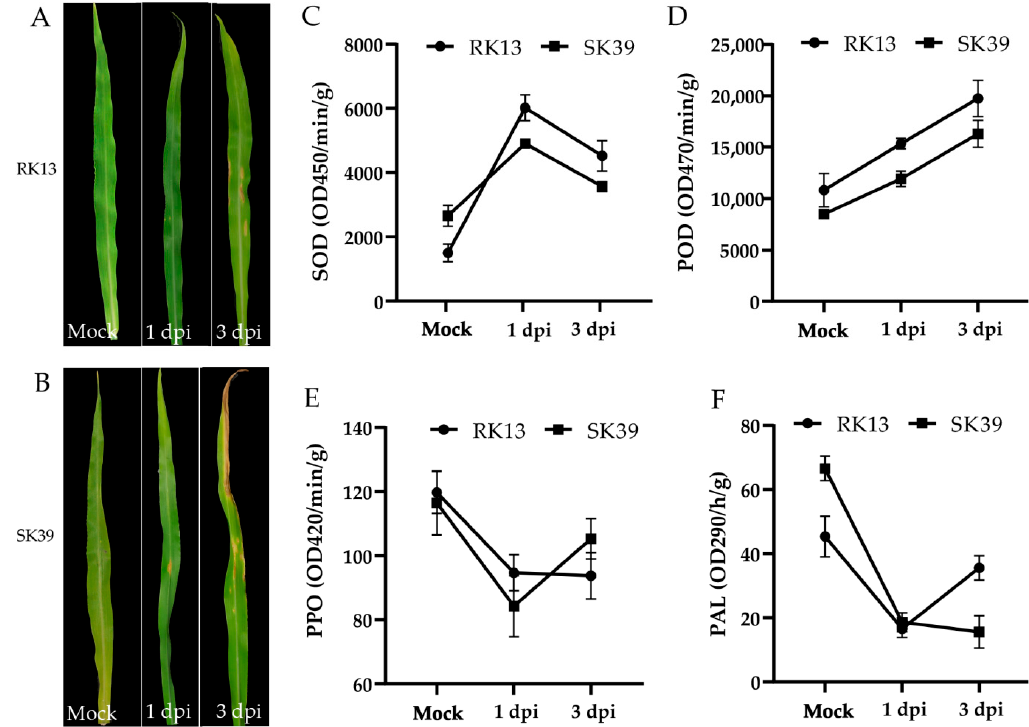
Figure 1. Morphological characteristics and changes in protective enzymes of leaves without pathogens (Mock) and with C. heterostrophus after inoculation (1 dpi, 3 dpi). ( A , B ) Morphological characteristics of leaves in RK13 ( A ) and SK39 ( B ). ( C – F ) The changes in protective enzymes (SOD, POD, PPO, and PAL) after inoculation with pathogens.